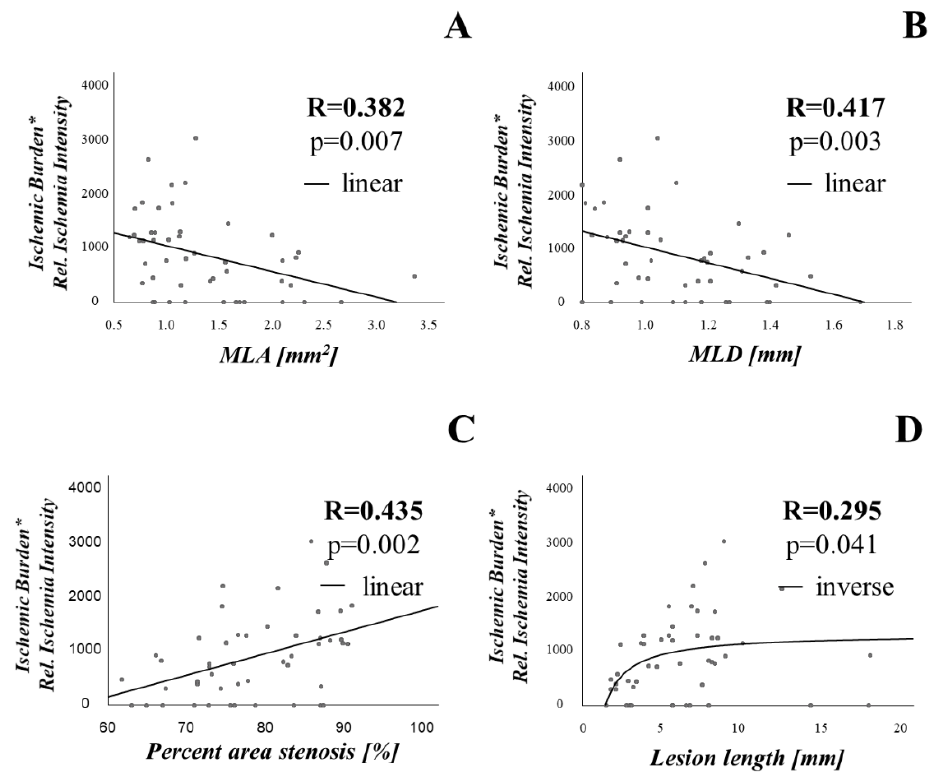
Figure 5. Stenosis geometry is associated with a composite index assessing both the extent and intensity of ischemia. As a surrogate parameter assessing both extent and intensity of ischemia, we calculated the product of ischemic burden and relative signal intensity of ischemic areas. This value, plotted on the Y-axis, was consistently associated with lesion geometry. The association with MLA ( A ), MLD ( B ), percent area stenosis ( C ) and lesion length ( D ) is shown. Abbreviations as in previous figures. * is represented multiplication sign.